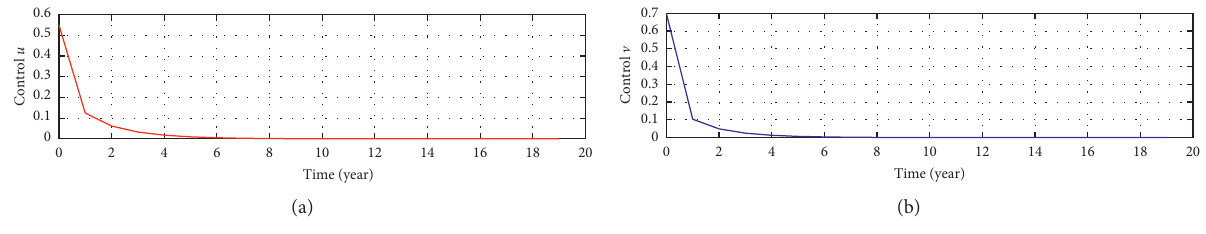
Figure 5: Time evolution of optimal controls u ∗ and v ∗